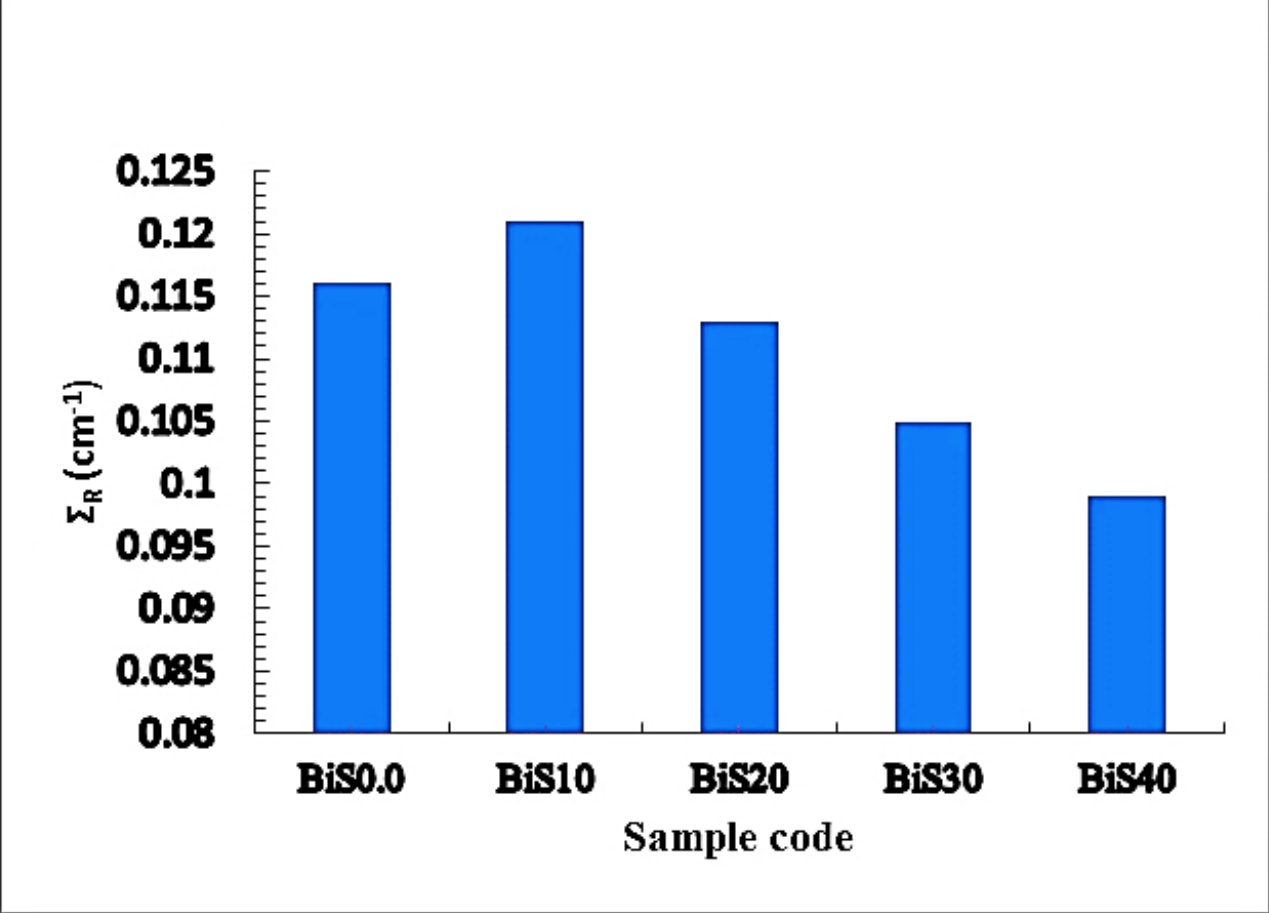
Figure 15. Ʃ R for all present glass samples. Figure 15. Σ R for all present glass